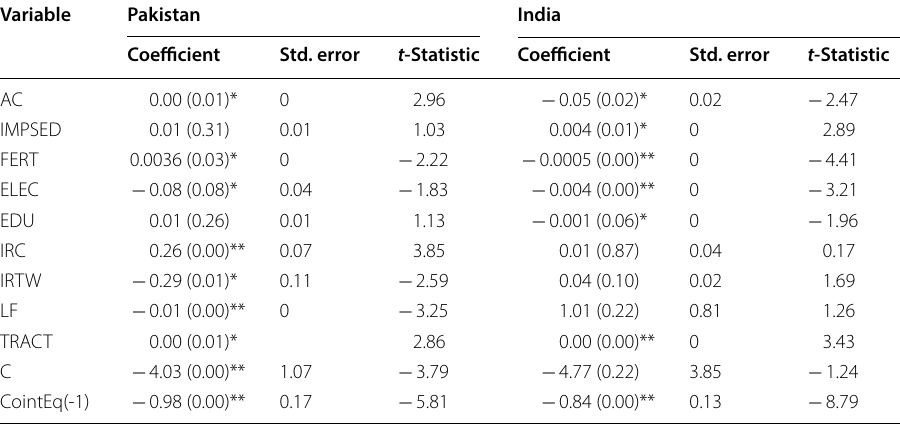
Table 3 Total factor productivity of cotton long-run